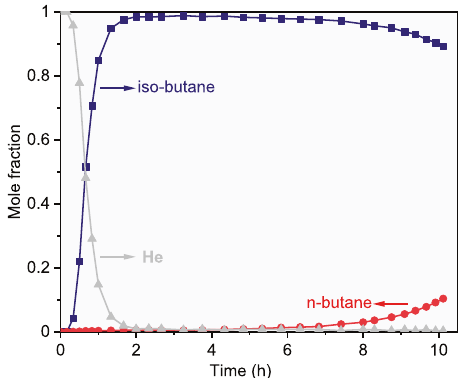
Fig. 6 | Gas mixture column breakthrough results. Column breakthrough curve for a n-butane(1)/isobutane(2) gas mixture ( z 2 = 59 mol%) using ZIF-8(30wt